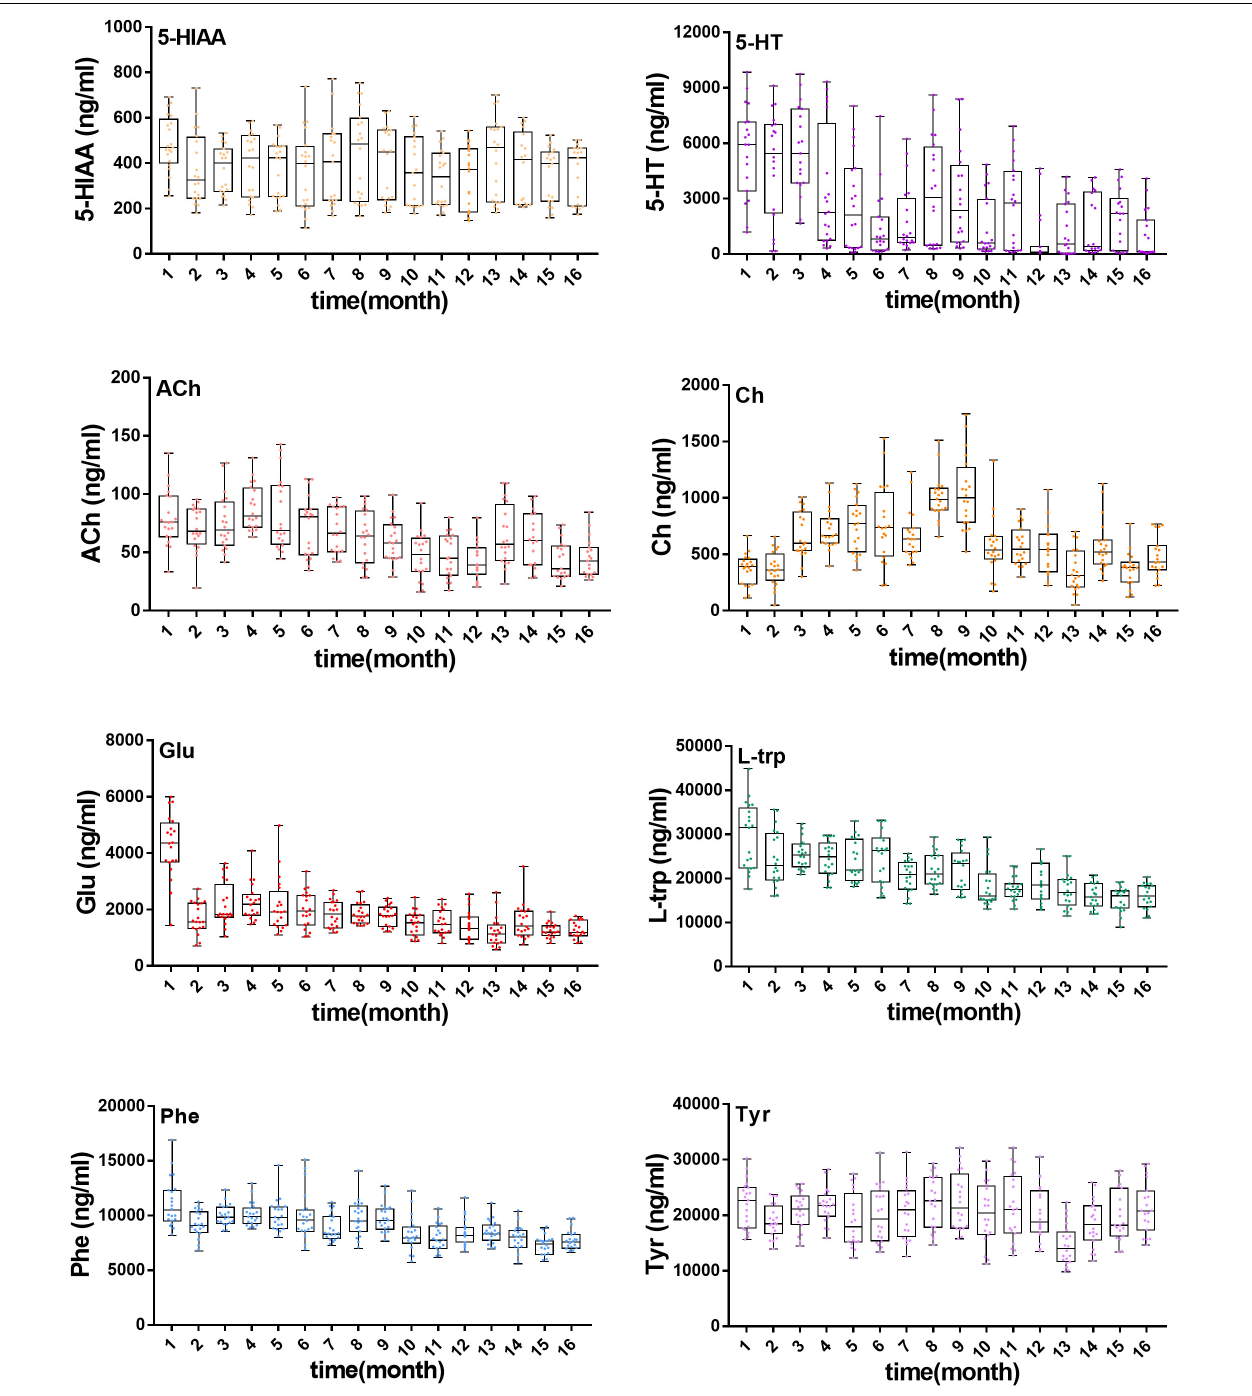
FIGURE 4 | Concentration of eight neurotransmitters in rat plasma during the growth of 18-month-old rats (from youth to old stage), including 5-HIAA, 5-HT, ACh, Ch, Glu, L-Trp, Phe, Tyr.